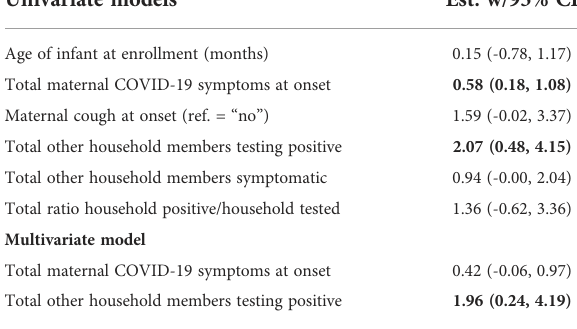
TABLE 6 Factors associated with probability of COVID-19 positivity infants of COVID+ mothers (positivity de fi ned as ever testing positive by PCR or IgG/IgA antibody